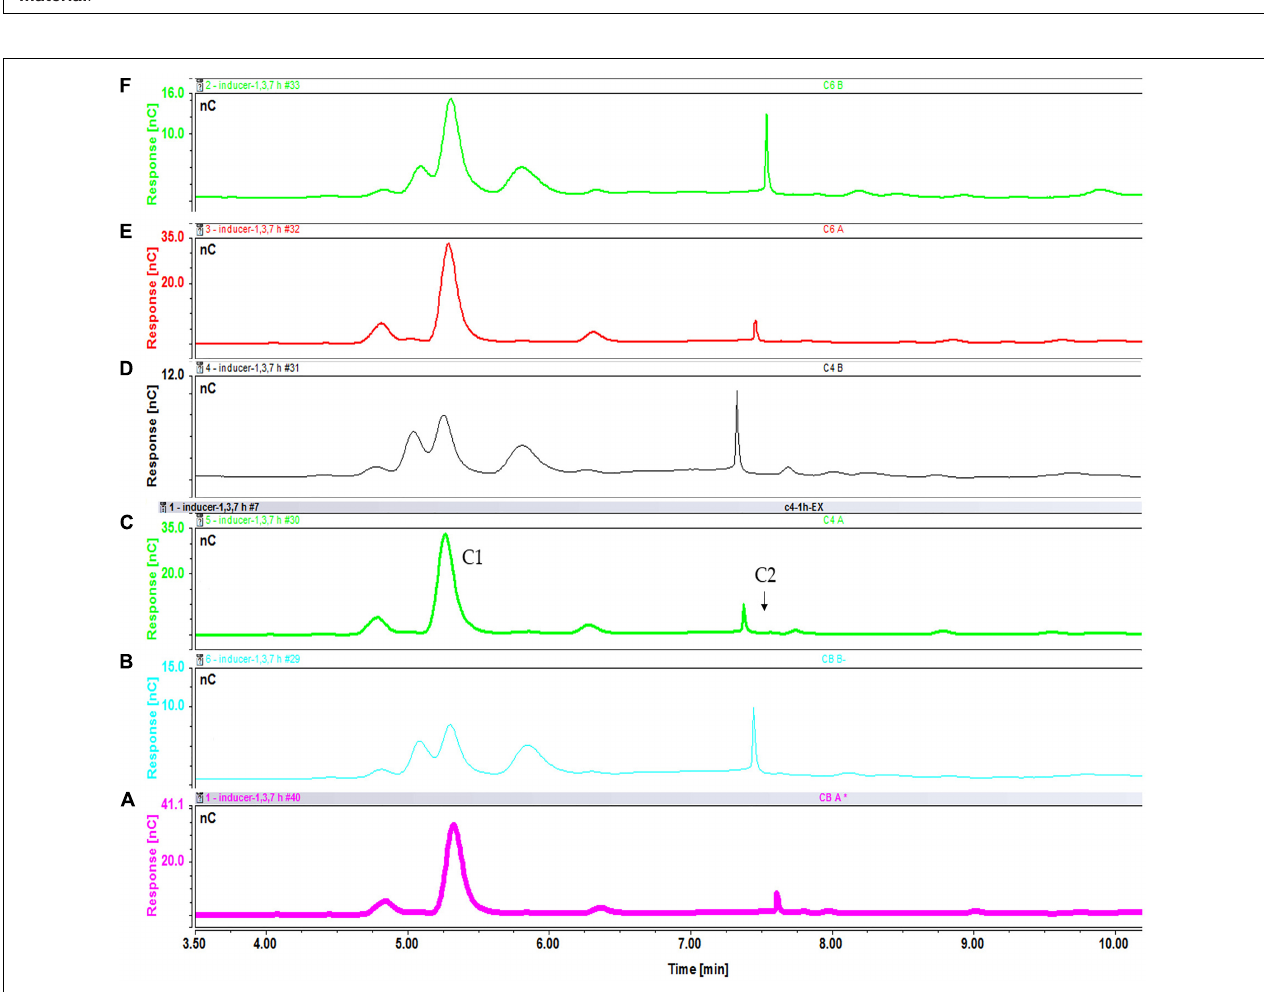
FIGURE 14 | Intracellular concentration of cellooligosaccharides after 1 h of induction with cellobiose fractions A (A) and B (B) ; cellotetraose fractions A (C) and B (D) ; and cellohexaose fractions A (E) and B (F) .